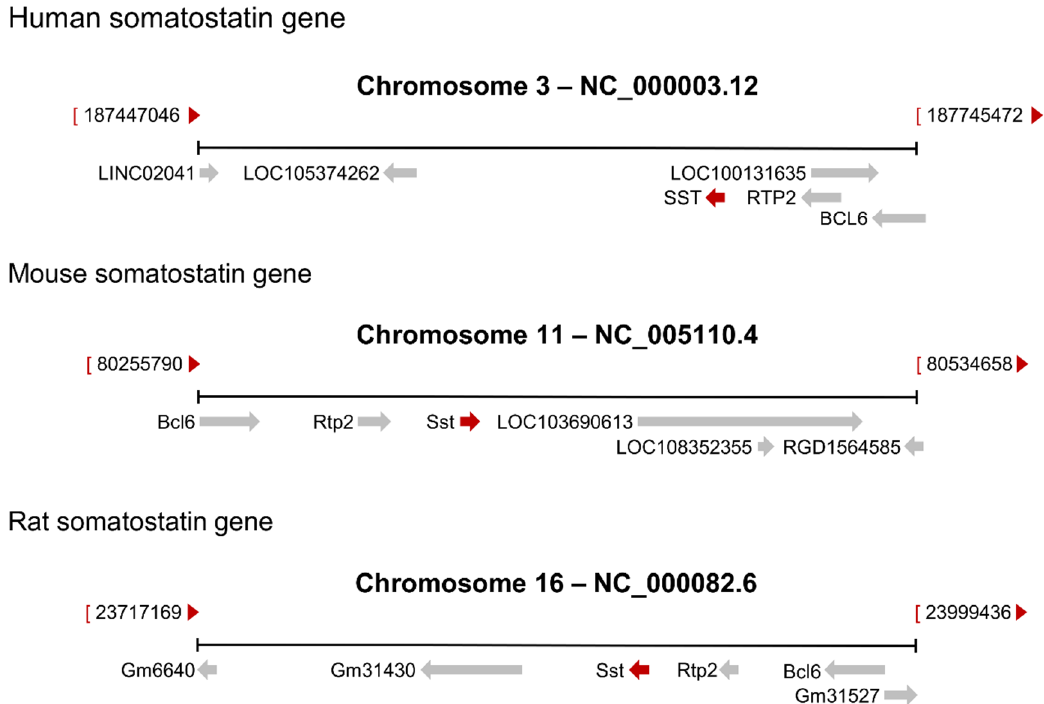
Figure 1. Genomic regions for the human somatostatin gene and the orthologue genes in rats and mice. Human somatostatin is located on chromosome 3, whereas mouse somatostatin is located on chromosome 11 and rat somatostatin on chromosome 16. Genomic contexts are conserved in the three species regarding the receptor transporter protein (RTP)2.